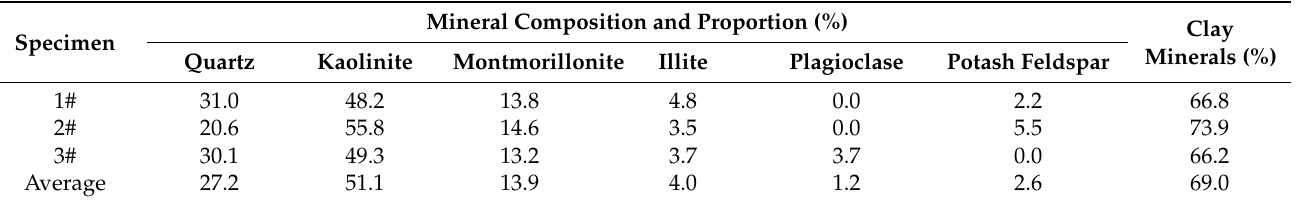
Table 2 Summaries the WCM mineral composition obtained from Figure 9. Table 2. Mineral composition of weakly cemented mudstone.